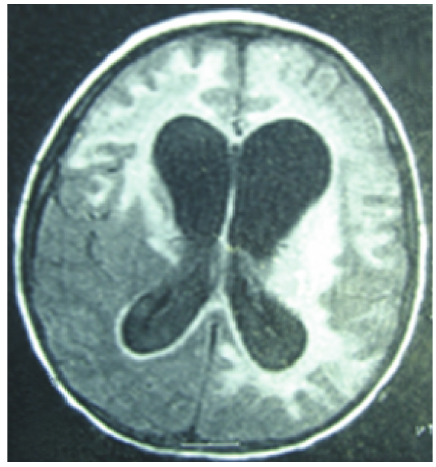
Figure 4: 3rd MRI, 4 months after onset of symptoms, 19 days post- HAART cessation.